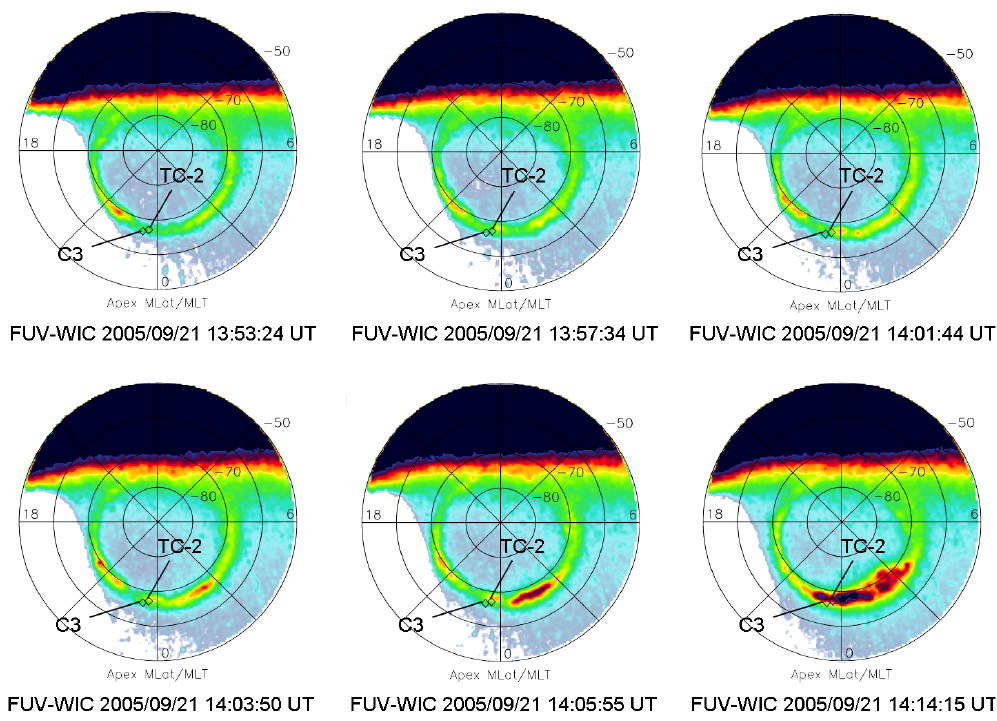
Fig. 2. Auroral images of the South polar region, in AACGM Geomagnetic Latitude/Magnetic Local Time coordinates, taken by FUV-WIC on board the IMAGE spacecraft. The footprints of C3 and TC-2, as calculated from the T96 magnetic field model (Tsyganenko and Stern, 1996), are marked by black diamonds on each